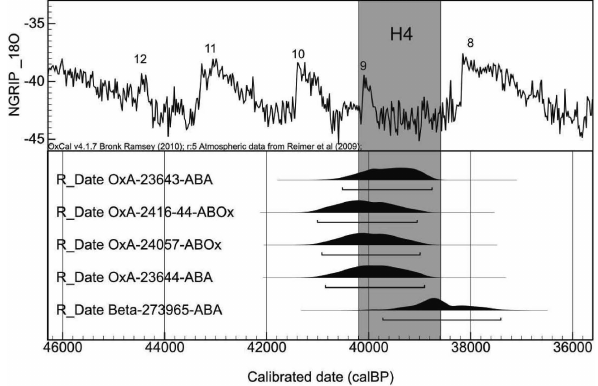
Fig. 2. Plot of the Canyars 14 C dates, calibrated with the Intcal09 curve (Reimer et al., 2009) and compared with the North Green- land Ice Core Project (NGRIP) δ 18 O ice-core record of Svensson et al. (2006) and Andersen et al. (2005), showing GI interestadials and Heinrich Event 4 according to Svensson et al. (2008) (prepared using OxCal vs. 4.1.7; Bronk Ramsey,